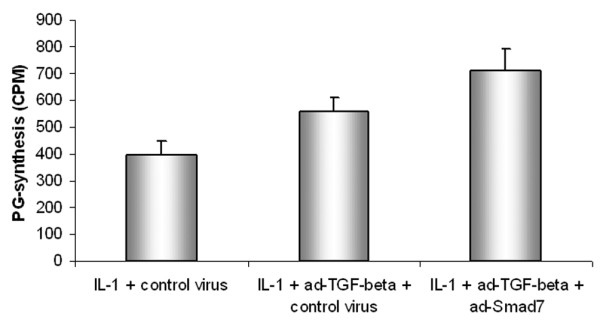
Proteoglycan (PG) synthesis in patellar cartilage after exposure to both transforming growth factor-β (TGF-β) and Smad7. PG synthesis was measured by 35SO42- incorporation into patellar cartilage 4 days after interleukin-1 (IL-1) injection. (CPM = counts per minute) Simultaneous injection of Ad-TGF-β and Ad-Smad7 significantly increased PG synthesis compared with IL-1 + control virus (p < 0.005) and therefore did not block 35SO42- incorporation. Error bars display standard error.